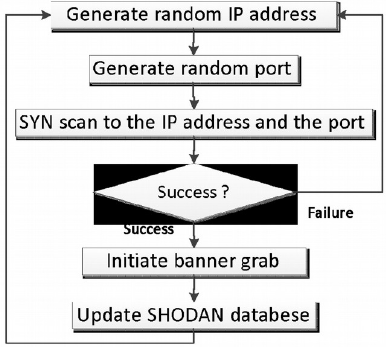
Figure 1. SHODAN scanning flow